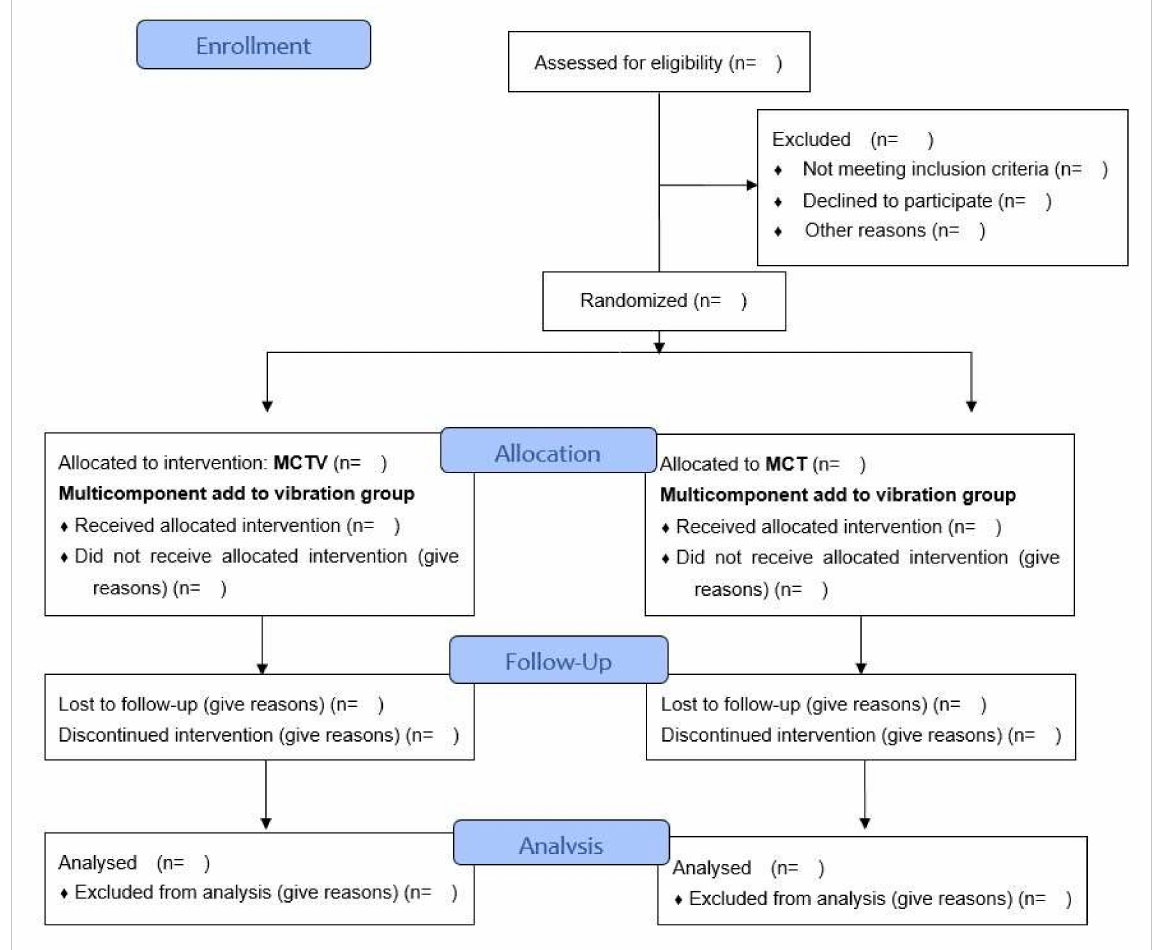
Figure 1. Consolidated Standards of Reporting Trials flow